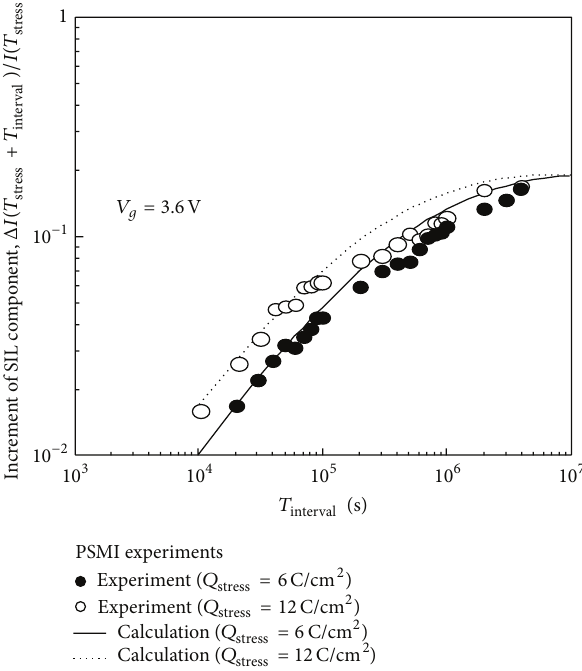
+ 𝑇 )/ stress interval = 12C/cm 2 . stress